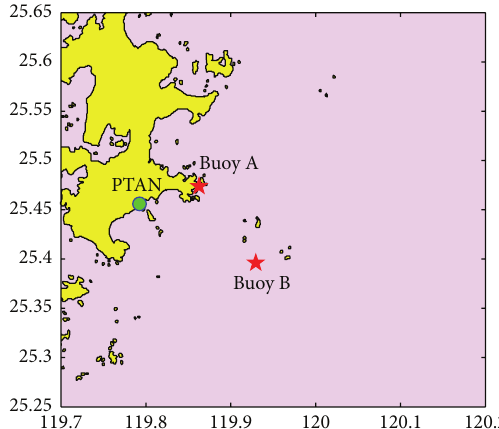
Figure 1: Geographic map of the observation system. PTAN is the radar operating at 13.5 MHz. Buoy A and Buoy B are the two buoys located in the sea area within radar detection range, 7.3 km and 15.3 km far from the radar,